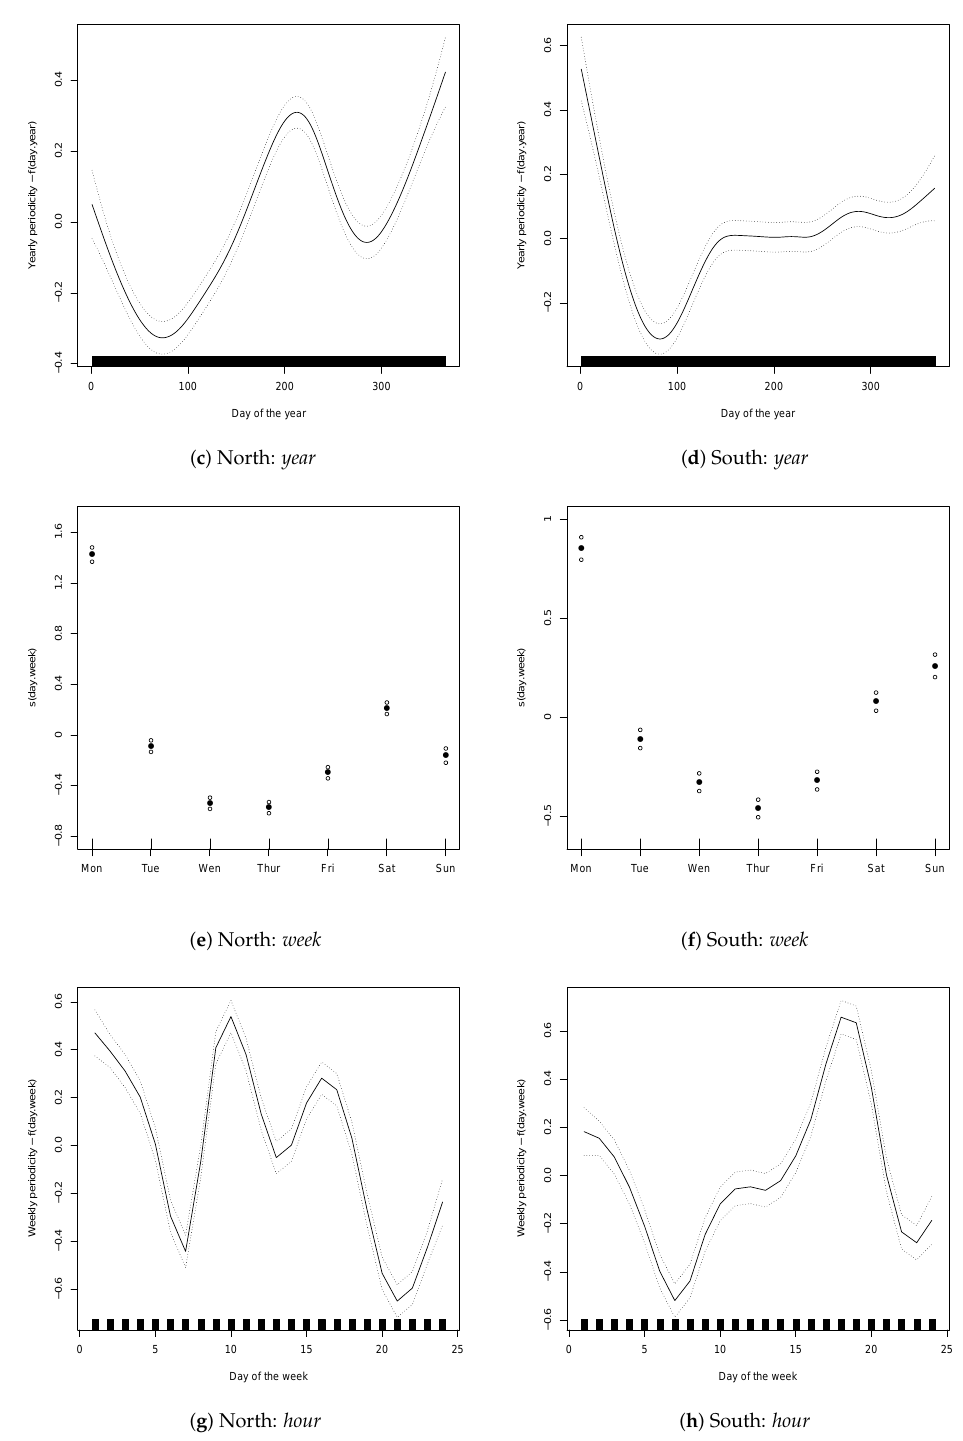
Figure 10. In-sample estimation results of the non-parametric additive model for the conditional variance of electricity demand. For both zones, each panel plots the estimated function h j ( · ) for the calendar effects and the overall